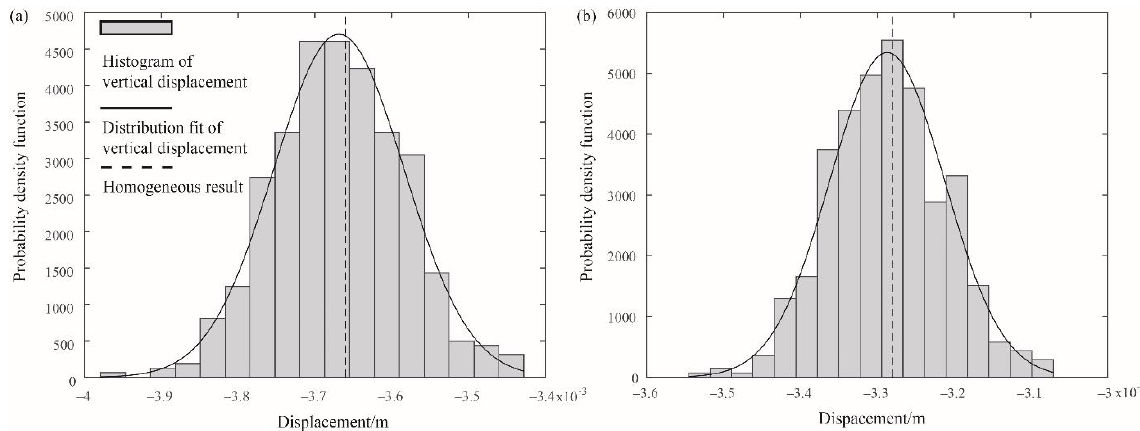
Figure 14. PDFs of the vertical displacement at the middle top point B of the elastic block from 500 realisations when the coefficient of friction is 0 ( a ) and 0.3 ( b ).